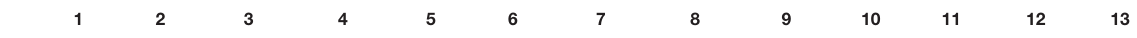
TABLE 7 | Correlations among different motivations—Chinese participants. Variable